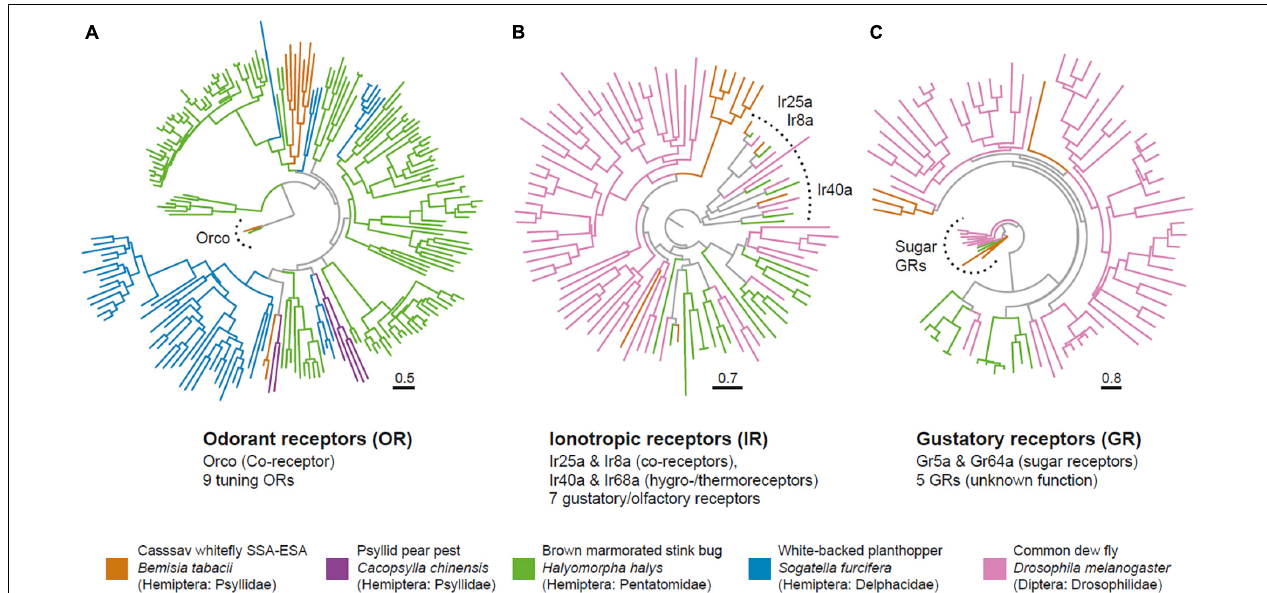
FIGURE 2 | The cassava whitefly has a greatly reduced olfactome. Phylogenetic trees of chemosensory proteins identified from the cassava whitefly B. tabaci SSA-ESA and select other insects showing the odorant receptors (A) , Ionotropic receptors (B) and Gustatory receptors (C) . Trees were generated in IQ-Tree, and branch support tested with Shimodaira–Hasegawa approximate likelihood ratio test with 1,000 replicates.